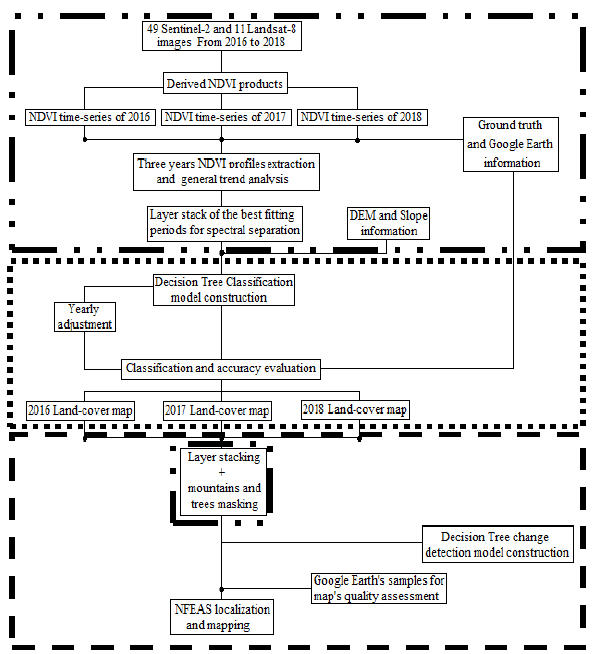
Figure 1. The workflow of the approach employed for land- cover mapping and NFEAS